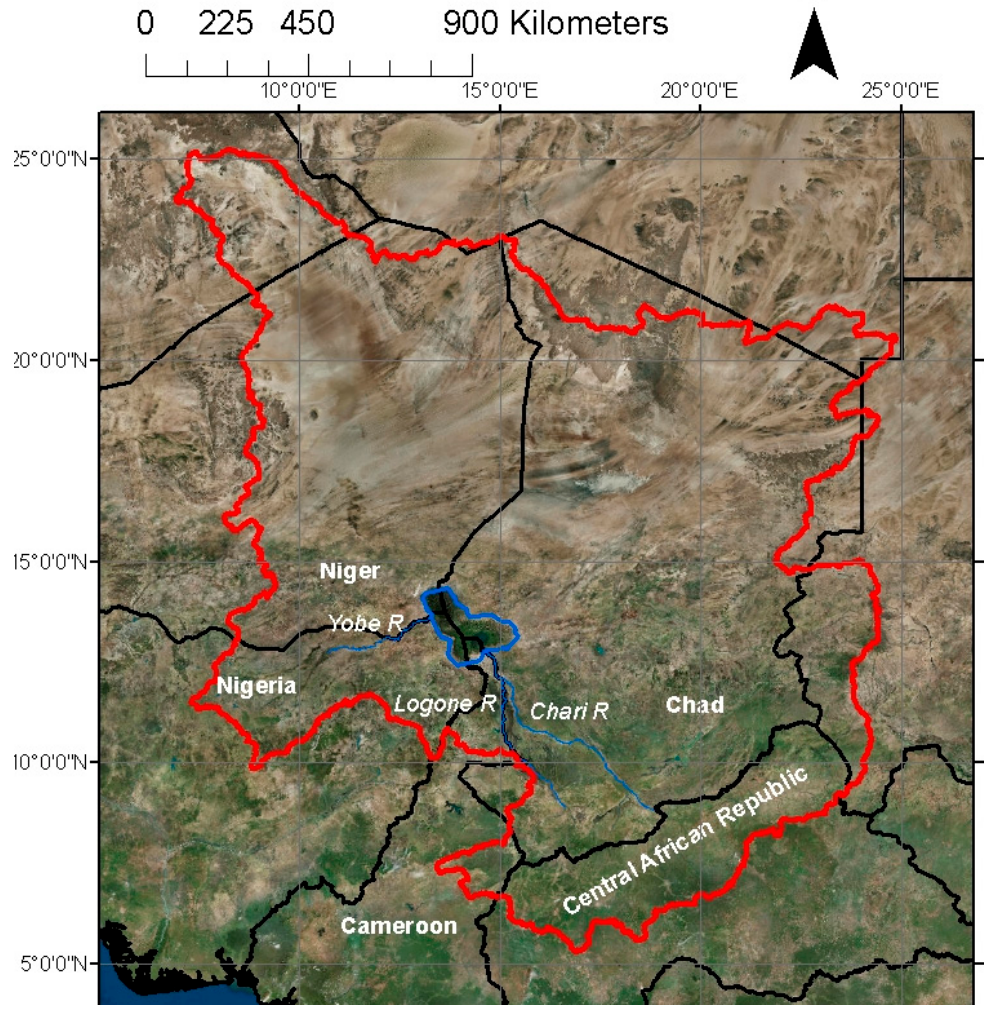
Figure 1. Lake Chad Basin ( red line ), Lake Chad and its main rivers ( blue lines ).